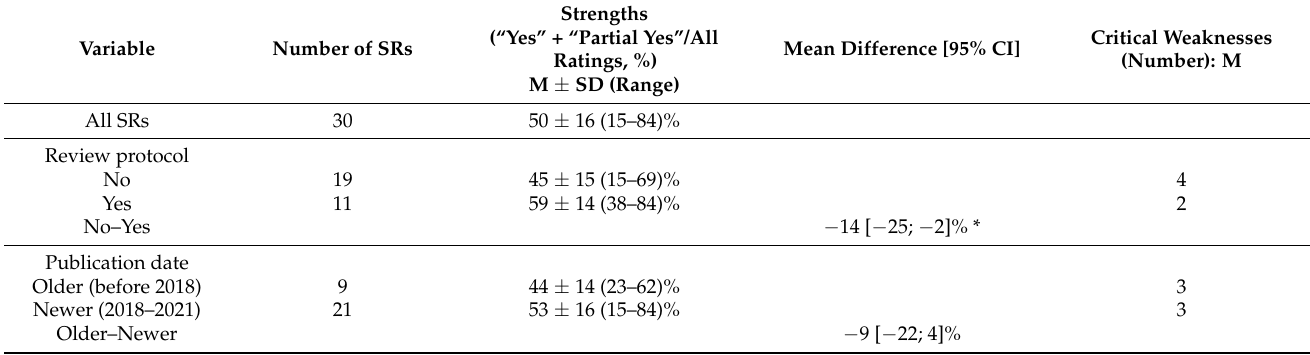
Table 3. Sensitivity analysis of SR strengths based on item ratings on AMSTAR